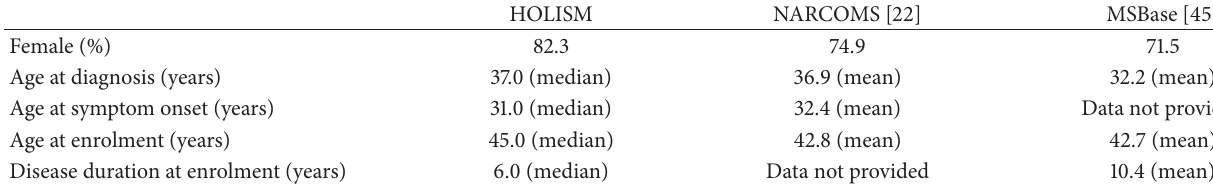
Table 9: Comparison of data with NARCOMS and MSBase